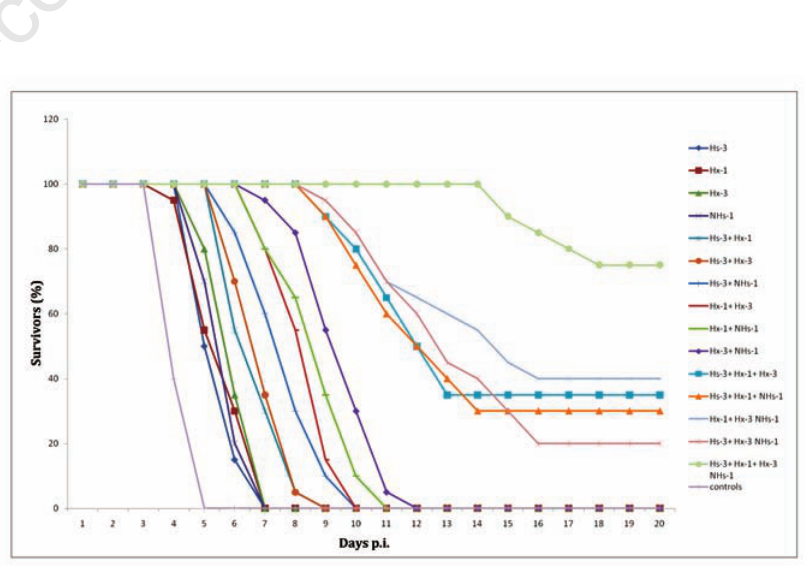
Figure 2. Protective effect of various combinations of monoclonal antibodies to Japanese encephalitis virus glycoprotein E on Japanese encephalitis virus (strain 691004) infected mice. Control mice were given normal immunoglobulin G or normal mouse